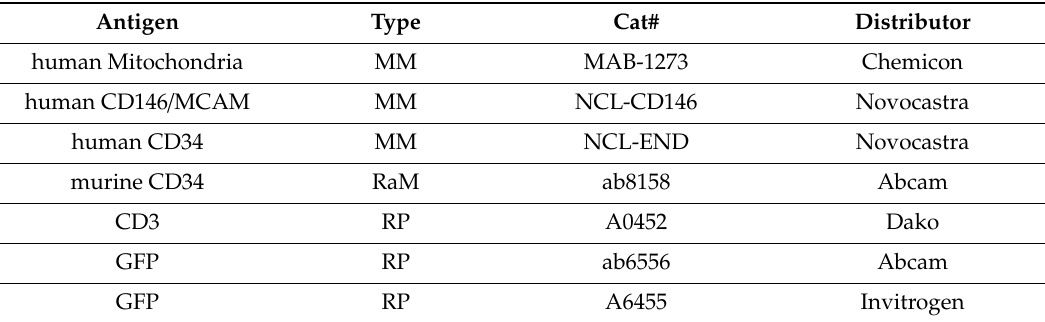
Table 2. Antibodies used for immunohistochemistry. Antigen Type Cat#